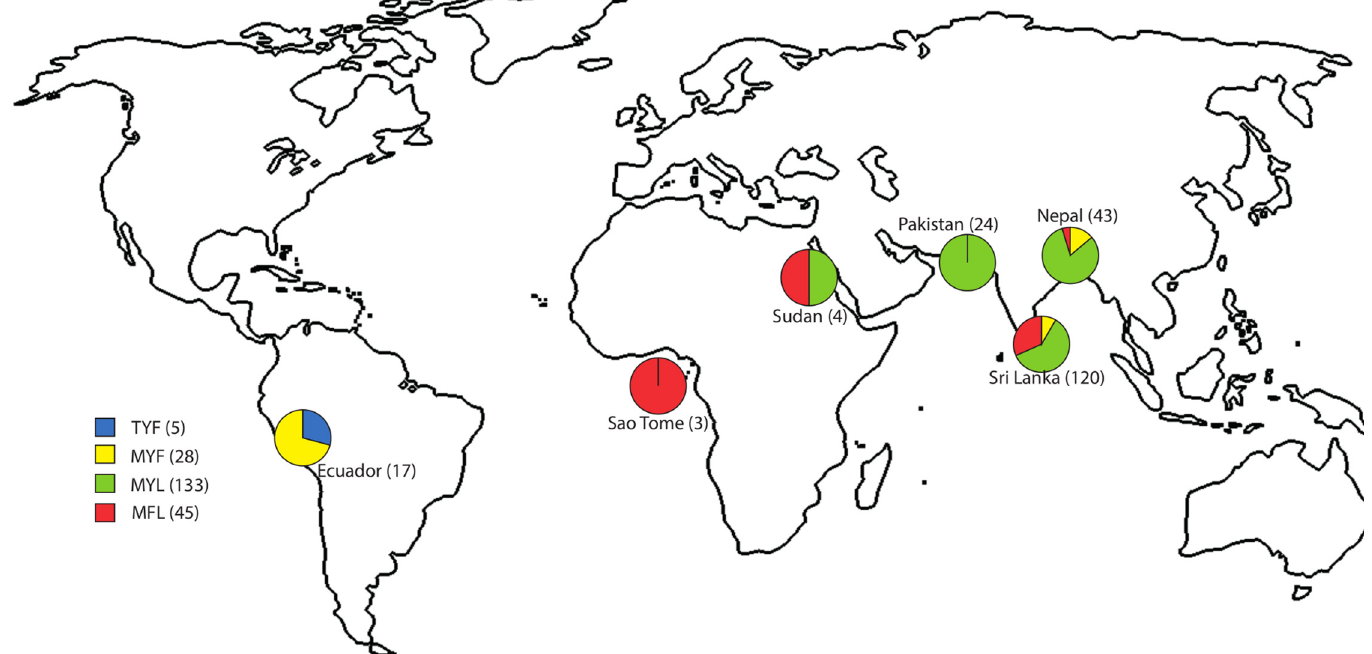
Fig 2. Pvmdr1 polymorphism in Plasmodium vivax samples collected at 8 geographical sites. Four Pvmdr1 alleles were detected in the study abbreviated as TYF, MYF, MYL and MFL. The TYF wild-type is shown in blue, MYF (single mutant, T958M) in yellow, MYL (double mutant, T958M+F1076L) in green, and MFL (triple mutant T958M+Y976F+F1076L) in red. The number of positive samples from each site is shown on the map in brackets, and the number of alleles and percentage frequency overall are shown in the legend.